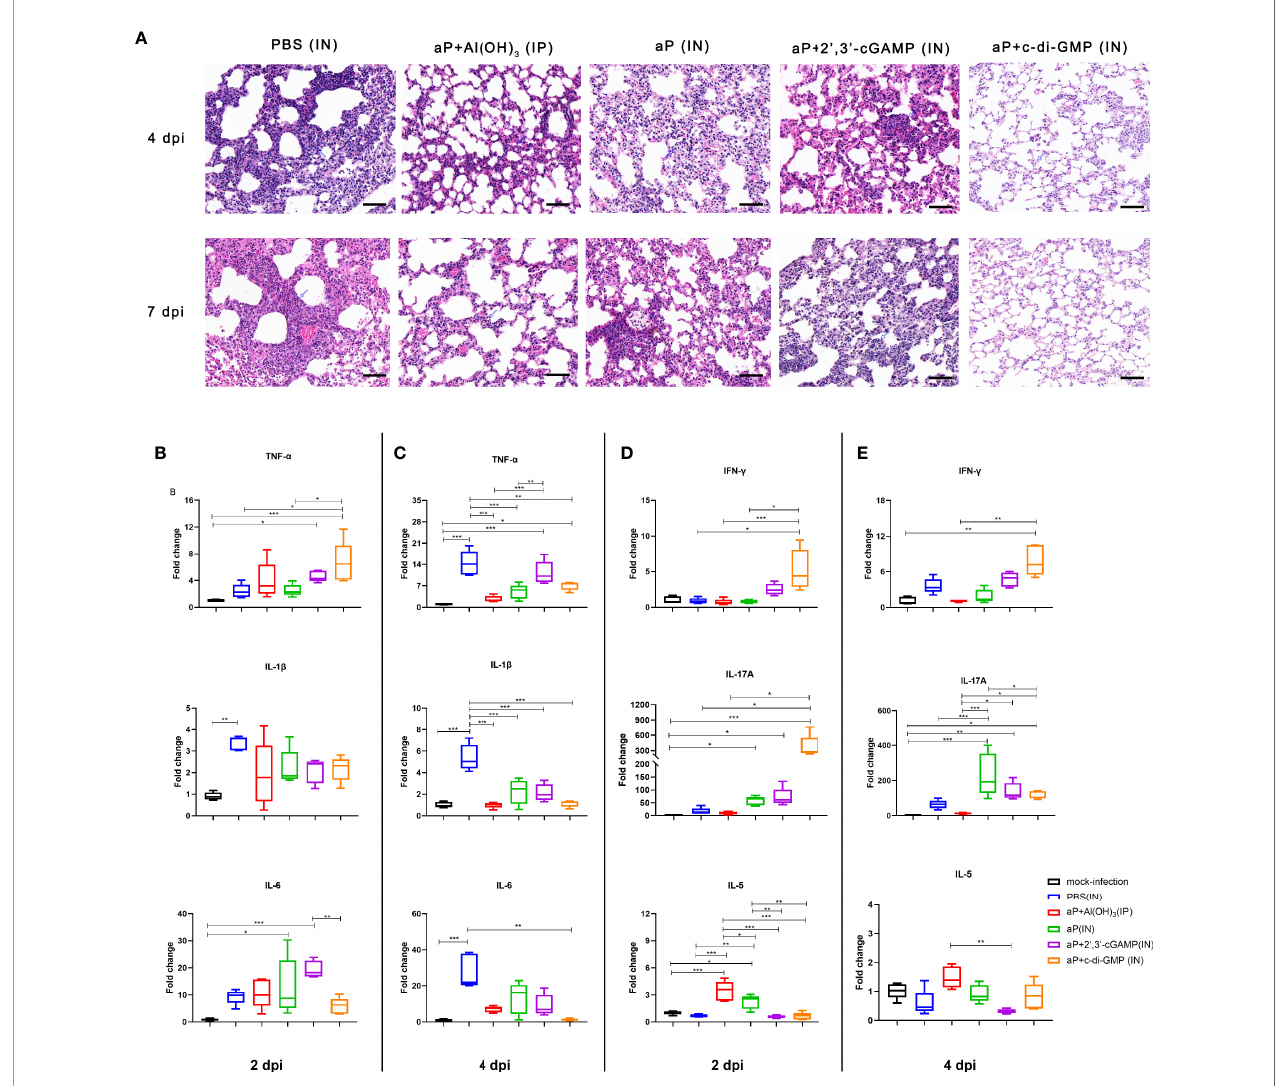
FIGURE 8 | IN immunization with the c-di-GMP-adjuvanted aP vaccine protects mice against lung disease caused by B. pertussis infection. (A) Images showing H&E staining following infection with B. pertussis . The images shown are from 4 dpi and 7 dpi for all groups. Scale bar, 50 m m. Each image is representative of a group of 5 mice at 4 dpi and 7 dpi. (B – E) Total RNA was extracted from the lungs of mice euthanized at day 2 and day 4 after B. pertussis challenge. Mouse TNF- a , IL-1 b , and IL-6 mRNA levels at 2 dpi (B) and 4 dpi (C) were quanti fi ed by RT – PCR. Mouse IFN- g , IL-17A, and IL-5 mRNA levels at 2 dpi (D) and 4 dpi (E) were quanti fi ed by RT – PCR. GAPDH mRNA was used as an internal control. Data are shown as the fold change in gene expression compared to that in mock-infected animals (unimmunized and challenged with PBS) after normalization. n = 5 animals for each time point. Data are expressed as the mean ± SEM. The P value is indicated as follows: * P < 0.05, ** P < 0.01, *** P < 0.001. See also Supplementary Figure 3